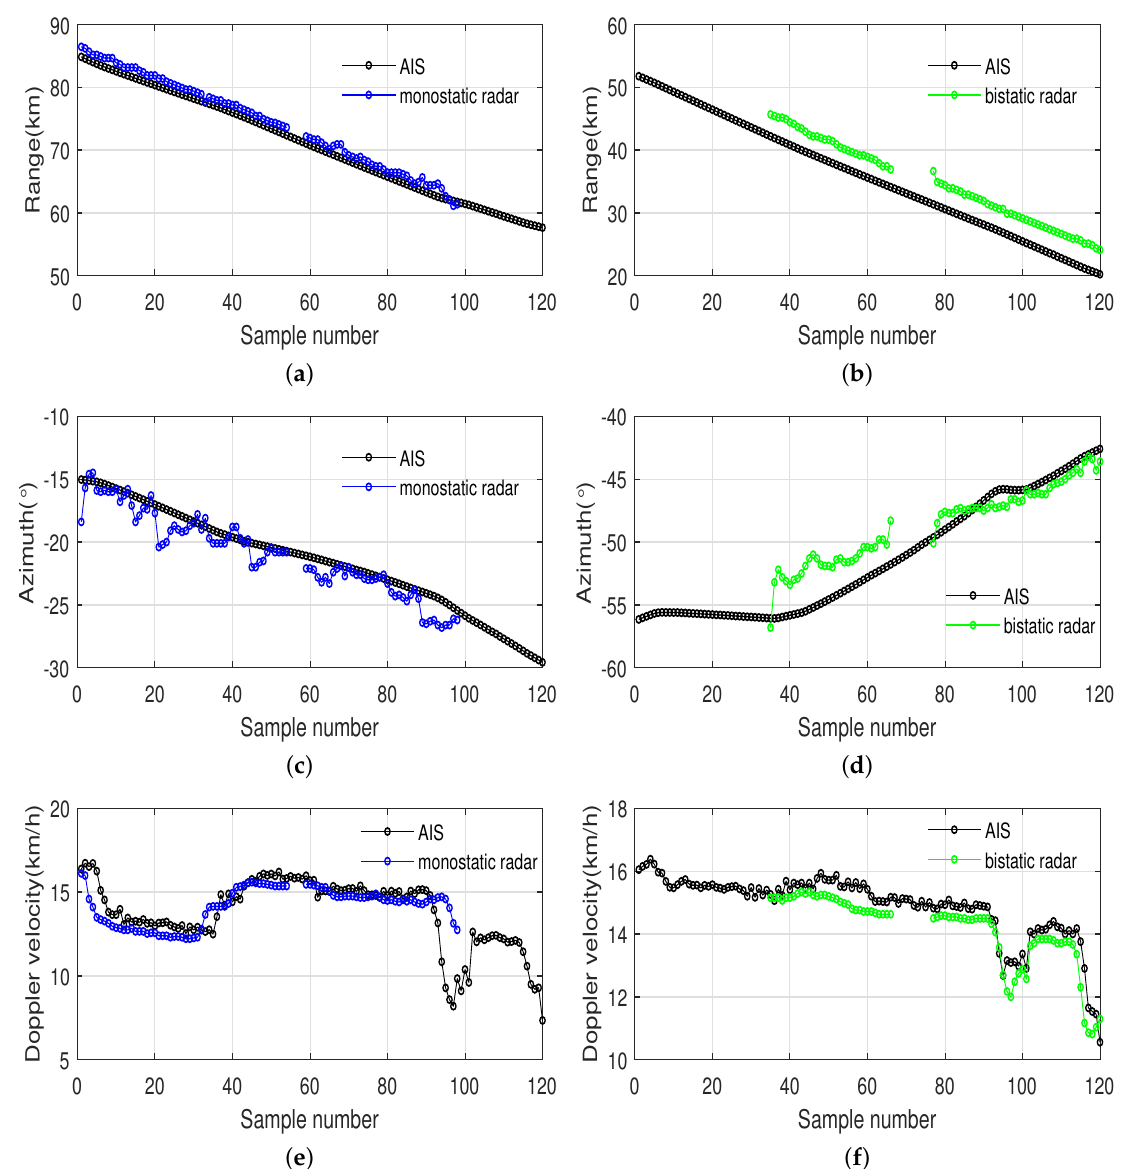
Figure 6. Kinematic parameter comparisons for target 1. ( a ) Range comparison for monostatic radar. ( b ) Range comparison for bistatic radar. ( c ) Azimuth comparison for monostatic radar. ( d ) Azimuth comparison for bistatic radar. ( e ) Doppler velocity comparison for monostatic radar. ( f ) Doppler velocity comparison for bistatic radar. Table 2. Root-mean-square error (RMSE) of range, azimuth and Doppler velocity for target 1. Range